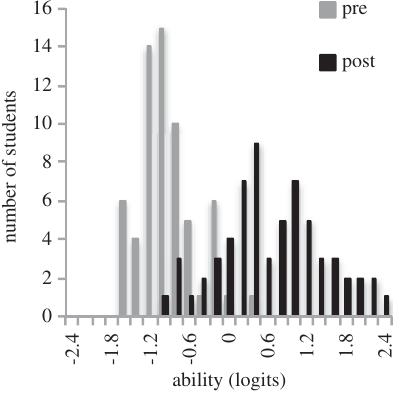
FIG. 20. The pre- and postability histogram for class